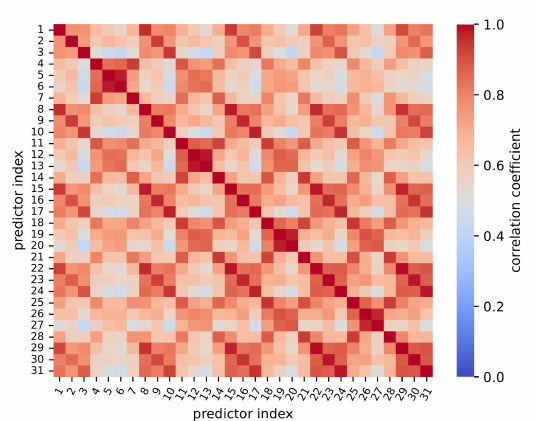
Figure 13. Visualization of the correlation matrix for predictor setting 31 b for the testing dataset. The predictor index refers to the position of a predictor variable as occurring in (21) within the concatenated tuple (22). In particular, higher correlations occur for pairs of predictors of the same type, but different time windows T w used for averaging.